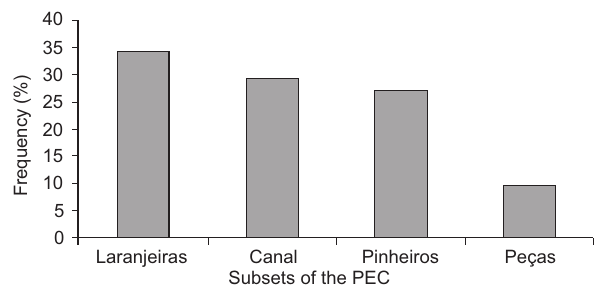
Figure 2. Frequency of occurrence of S. guianensis groups observed in four distinct subsets of the Paranaguá Estuarine Complex (PEC), Brazil, between April 2006 and July 2008.